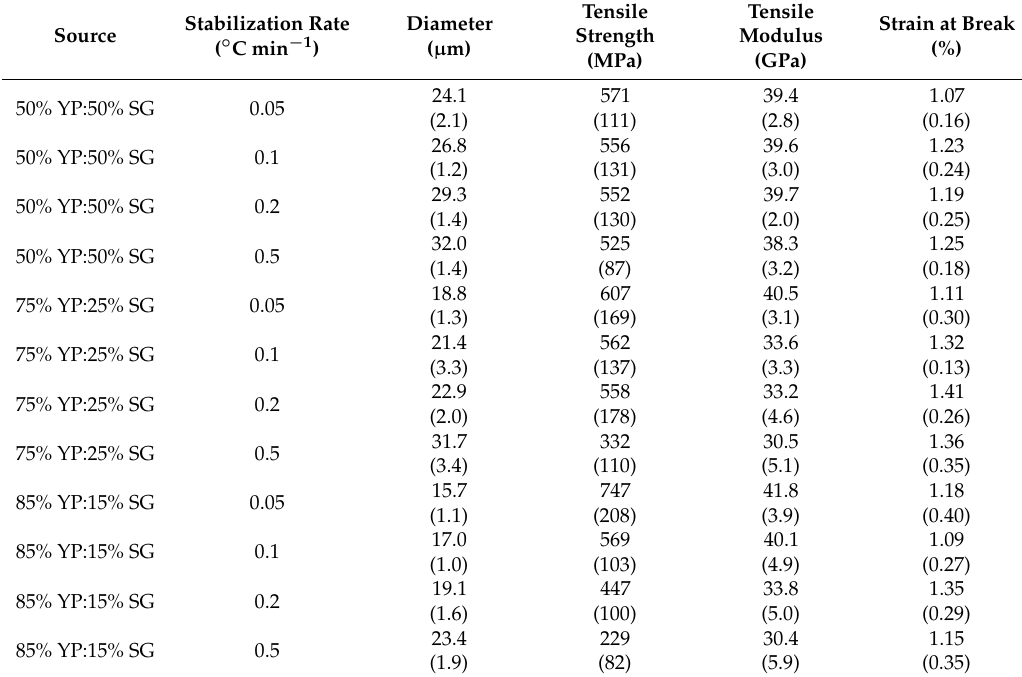
Table 6. Mechanical properties of carbon fibers made from different ratios of switchgrass and yellow poplar lignin blend a .